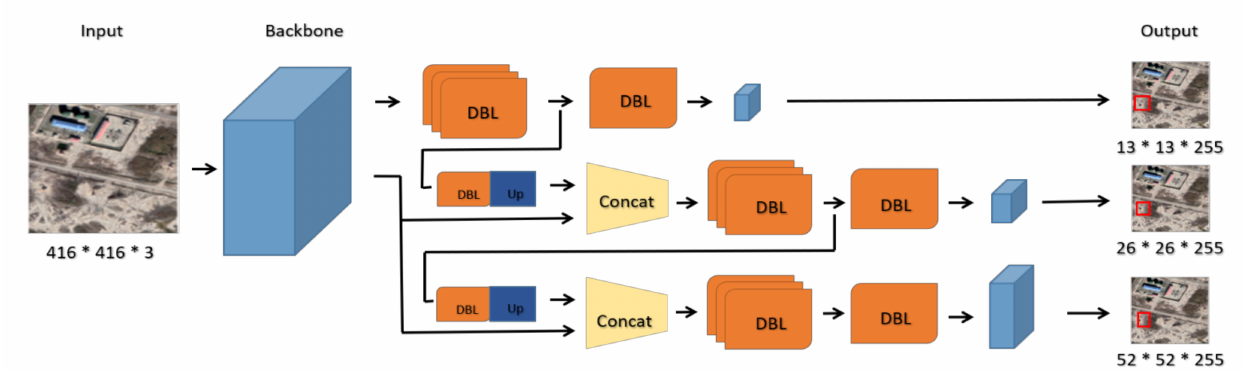
Figure 9. You Only Look Once (YOLO) v3 framework (with Darknet-53